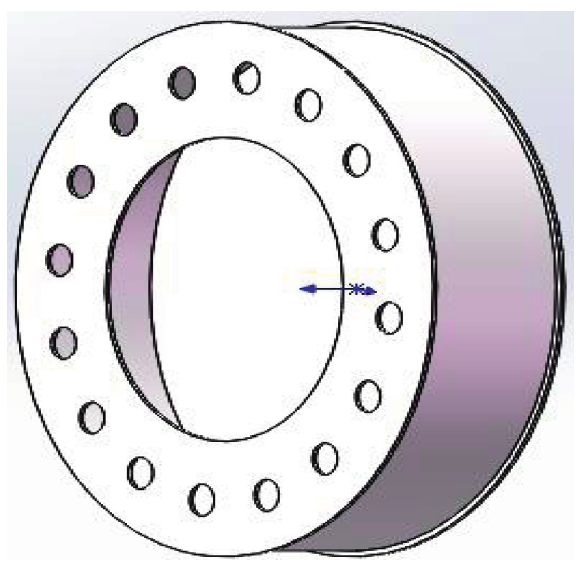
Figure 5: Structure diagram of the rear smoke